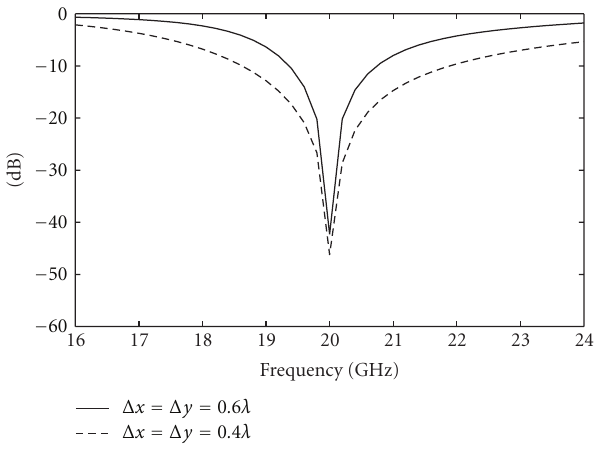
Figure 12: Simulated return